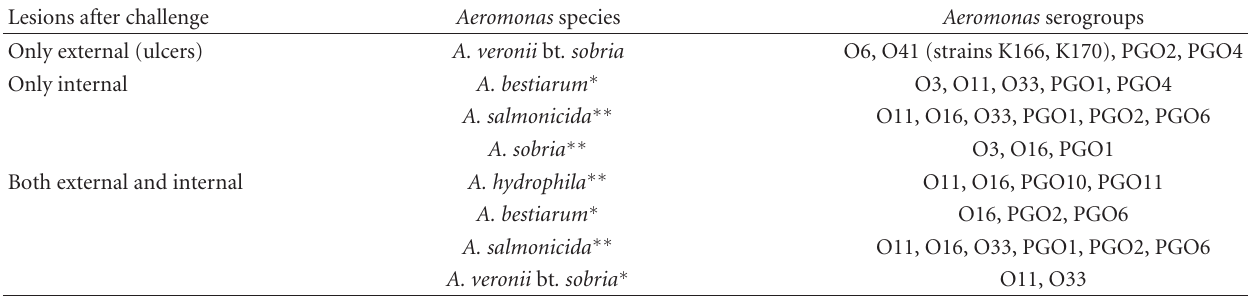
Table 3: Disease symptoms in challenged trout in relation to Aeromonas species and serogroups.